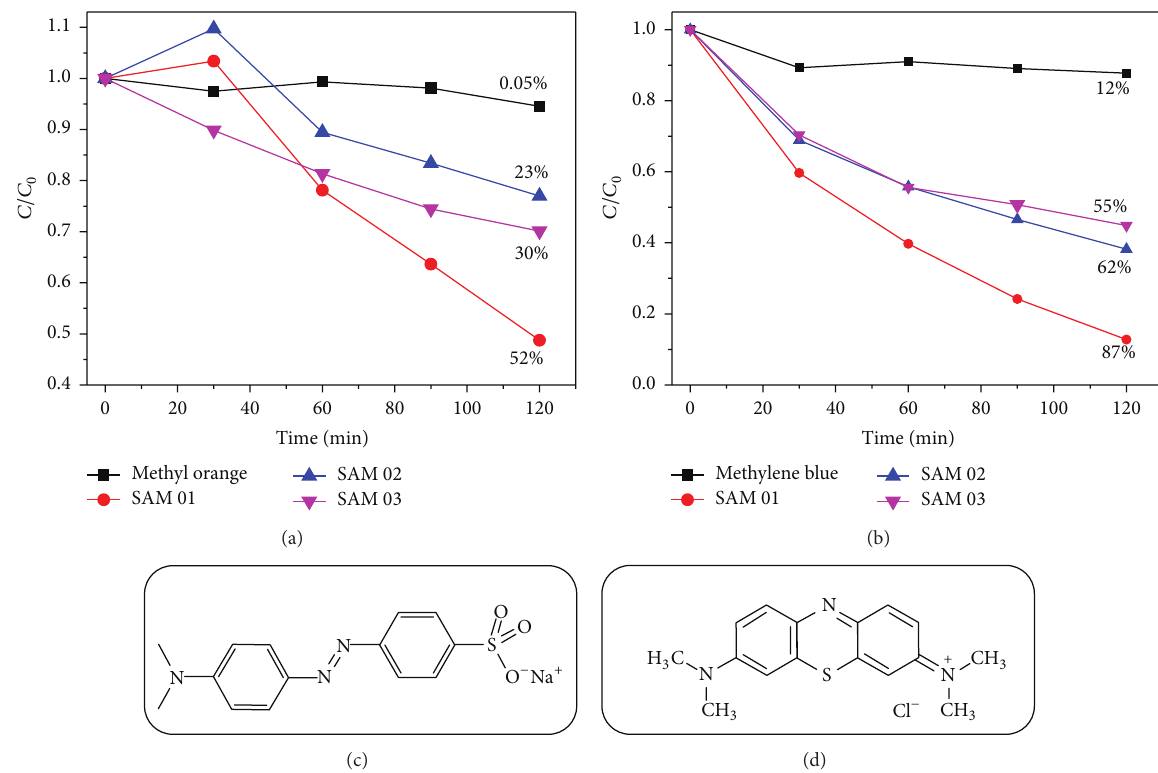
Figure 7: Photodegradation profiles of the methyl orange solution, using TiO 2 nanoparticles with UVC light (a) and of the methylene blue solution, using TiO 2 nanoparticles with UVC light (b). The numbers indicate the degradation percentage compared to initial concentration used. Methyl orange molecular structure (c) and methylene blue molecular structure (d).